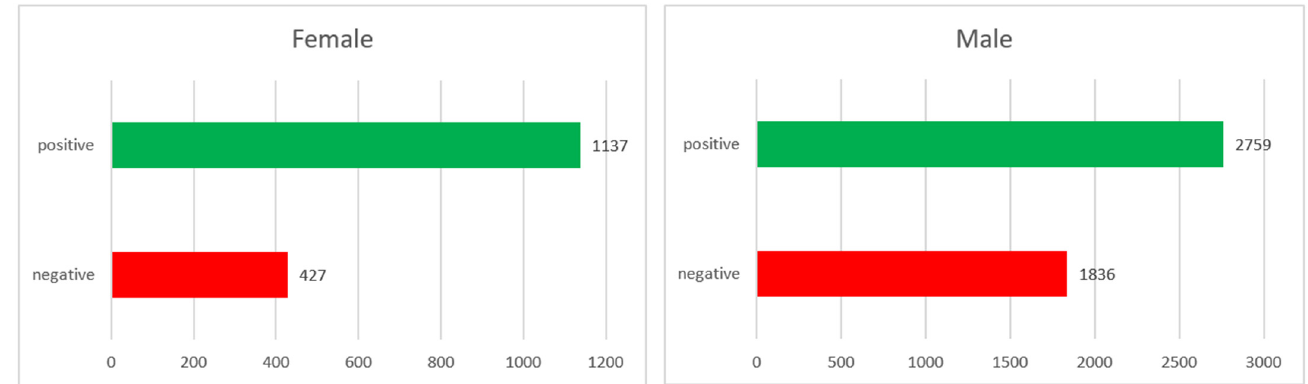
Figure 12. Polarity of comments by gender. Green—positive, red—negative.